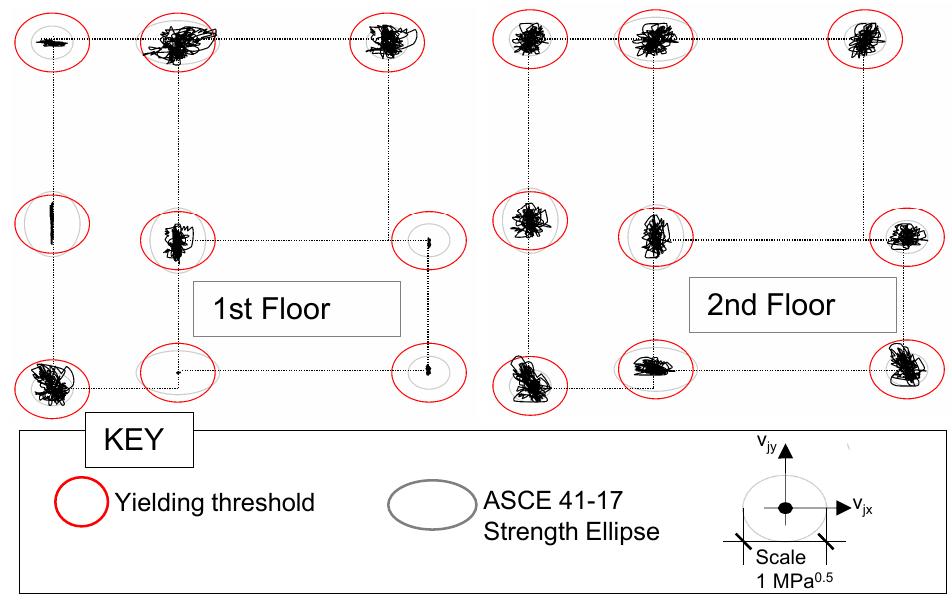
Figure 16. Bi-axial shear demand of beam–column joint obtained with NLTH (Case of +x and +y excitation). The reader is referred to the color version of this